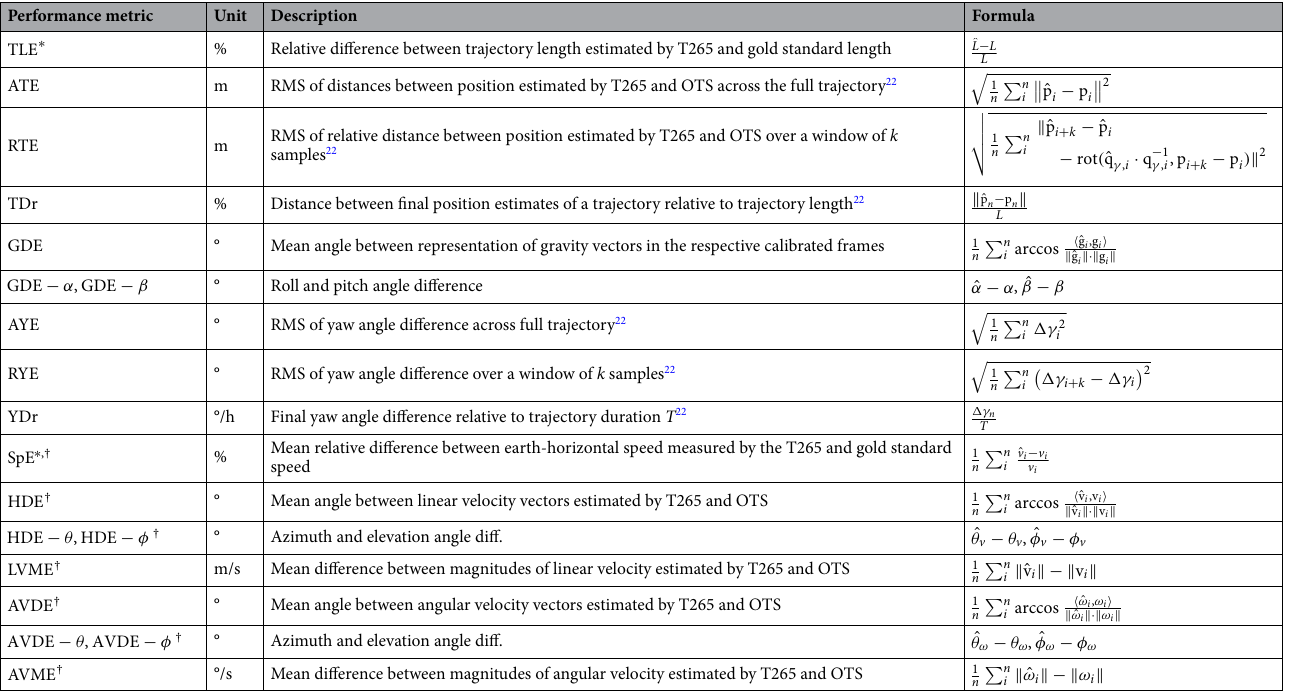
) were computed for both studies, ∗